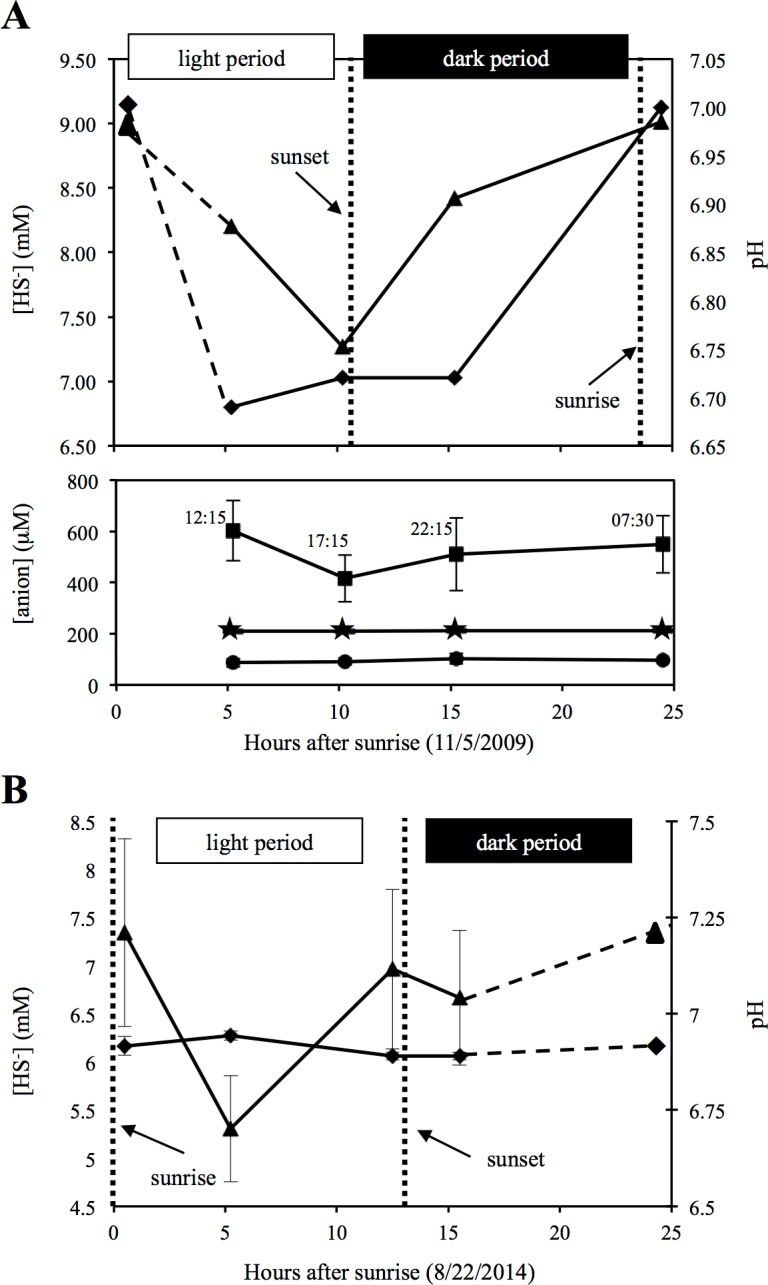
Geochemistry of Zodletone spring’s source water.Geochemistry of Zodletone source water over the time course of the experiment is shown at the top (A). Dashed lines indicate an extrapolation of the data from the 07:30 (early morning) time point. Dotted vertical lines indicate sunset and sunrise on day(s) of sampling. Above: triangles and diamonds indicate sulfide concentrations and pH values, respectively. Below: squares, stars, and circles indicate thiosulfate (S2O32−), sulfite (SO32−), and sulfate (SO42−) concentrations, respectively. Y-error bars represent the standard deviation of duplicate measurements for sulfate and triplicate measurements for thiosulfate. Sulfite, pH, and sulfide values were based on single measurements only. Source water was sampled again in August 2014 to measure pH and sulfide in triplicate and verify patterns of sulfide loss and generation during the day and night, respectively (B).